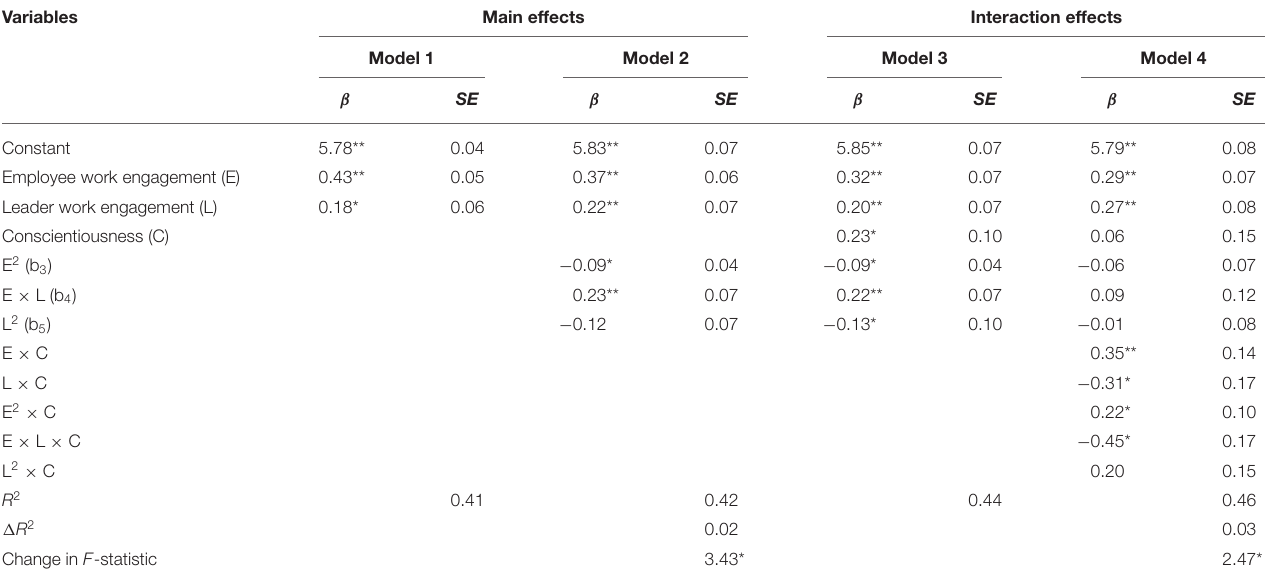
TABLE 3 | Cross-level polynomial regression results and path analysis results.